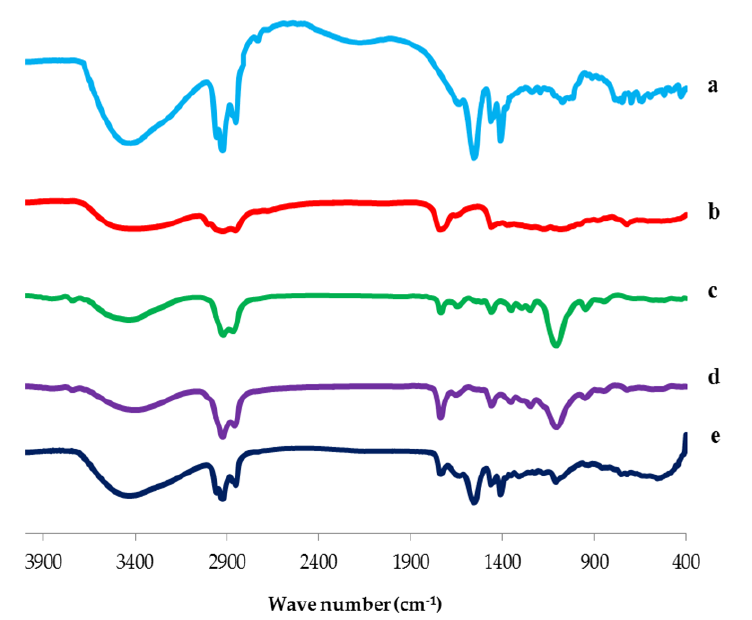
Figure 7. FTIR spectrum of ( a ) SV, ( b ) Span 60, ( c ) Cremophor RH, ( d ) Plain spanlastics and ( e ) optimized SV-loaded SNVs (F8). Abbreviations: SV, Sodium valproate.